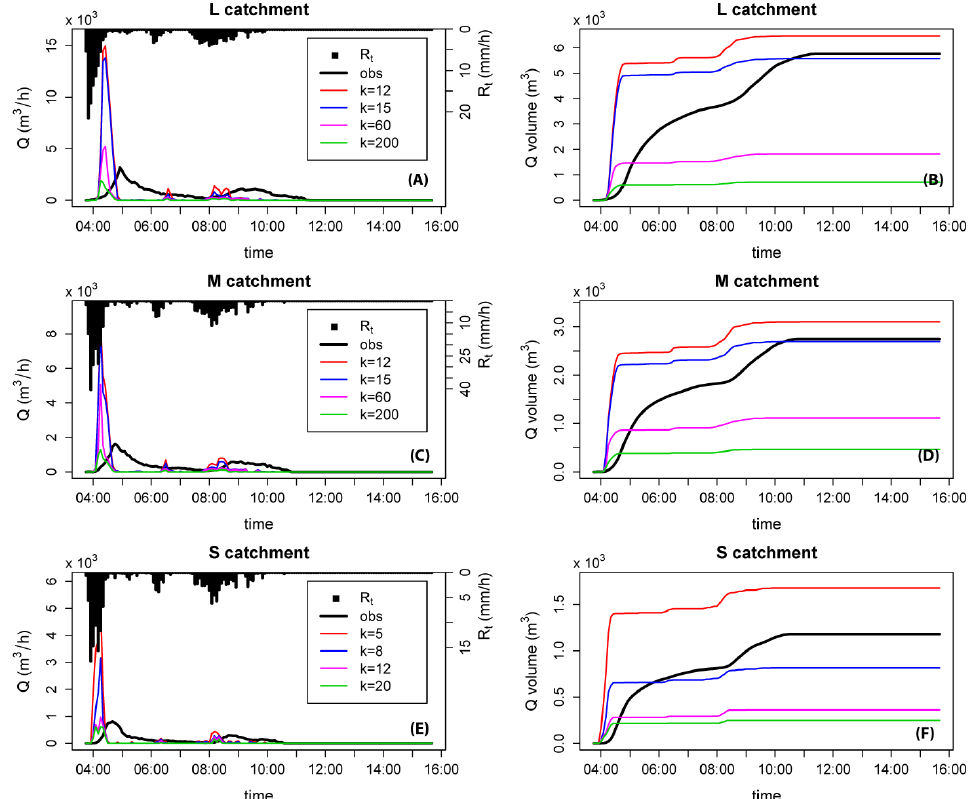
Fig. 9. Hydrographs (m 3 h − 1 , left panel: A, C, E ) and the corresponding cumulative discharge volume (m 3 , right panel: B, D, F ) from individual catchments simulated using the closure relation C ∗ with different calibration factors, k, for the event observed on 17 June 2010. Rainfall intensity ( R t , mmh − 1 ) is plotted on the secondary